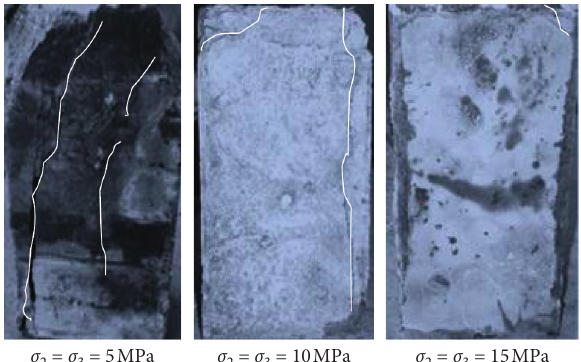
Figure 12: Unloading cracking morphology of rock-like specimens under different confining pressures.